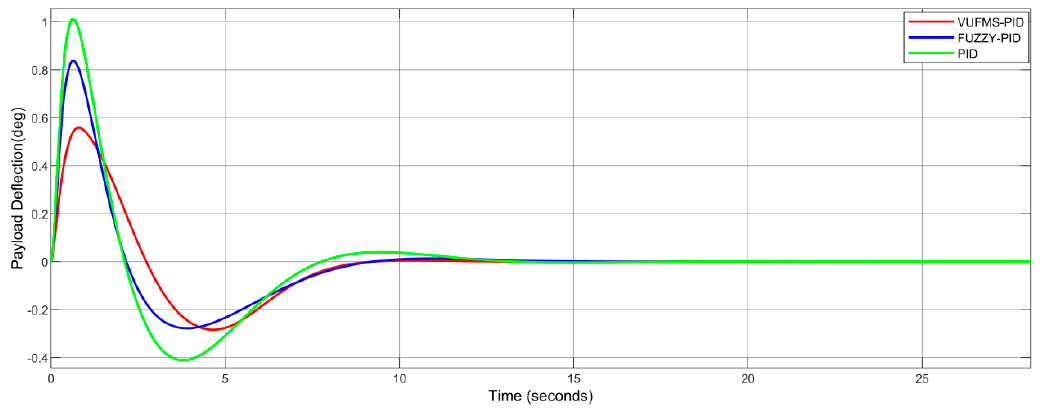
Figure 12. Trolley’s position using VUFMS-PID, FUZZY-PID and PID controller under working condition 3. Table 6. Performances obtained using VUFMS-PID, FUZZY-PID, and PID controller under work- ing condition 1. Output